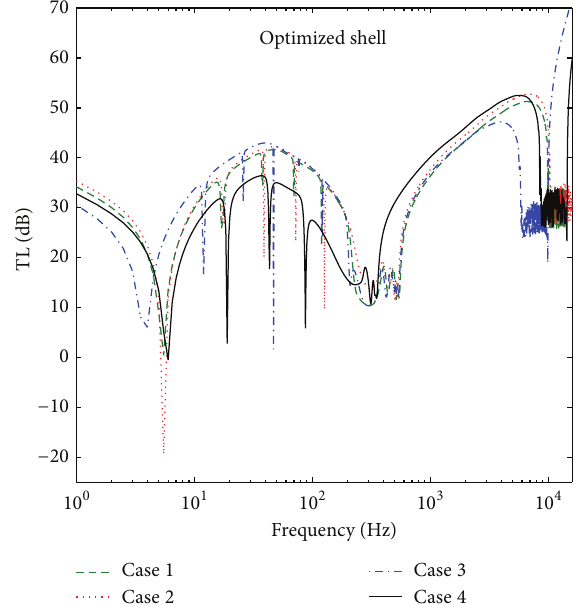
Figure 5: Comparison between TL- f curves for the FGM shells listed in Table 4.